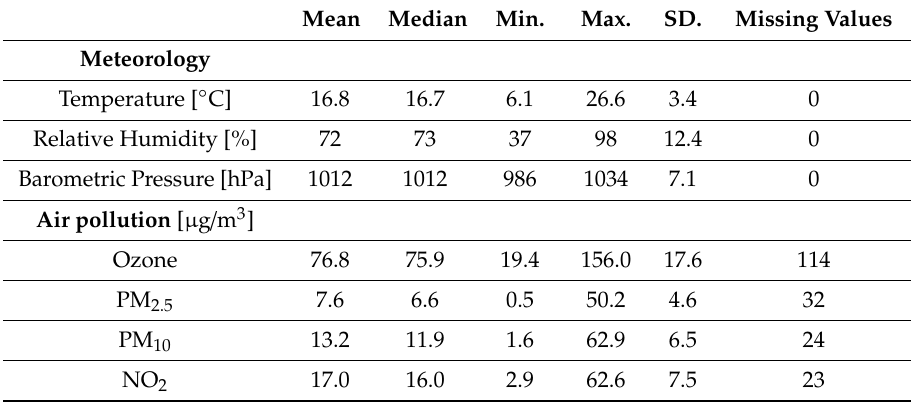
Table 2. Daily levels of temperature, relative humidity, barometric pressure, and air pollutants during summer months (June–August) in the Helsinki metropolitan area, Finland, 2001–2017.